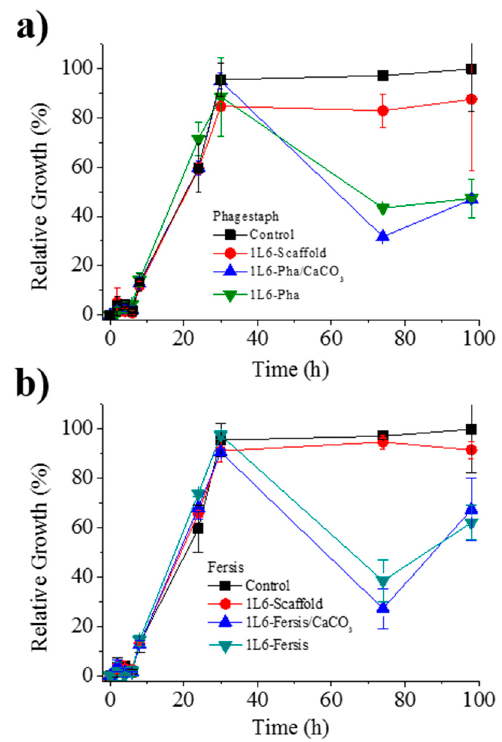
Figure 11. ( a ) Growth curves of the bacterium S. aureus in the presence of the control, the unloaded PEU 1L6 scaffolds and those loaded with Phagestaph as indicated in the legend. ( b ) Growth curves of the bacterium S. aureus in the presence of the control, the unloaded PEU 1L6 scaffolds, and those loaded with Fersis, as indicated in the legend. Table 3. Lytic activity of different preparations of Phagestaph and Fersis